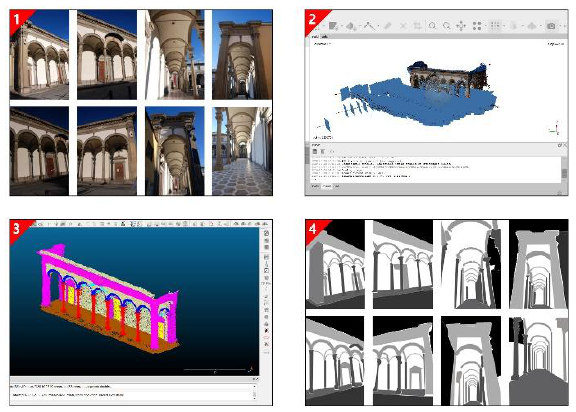
Figure 4 . The semi-automatic labelling procedure.